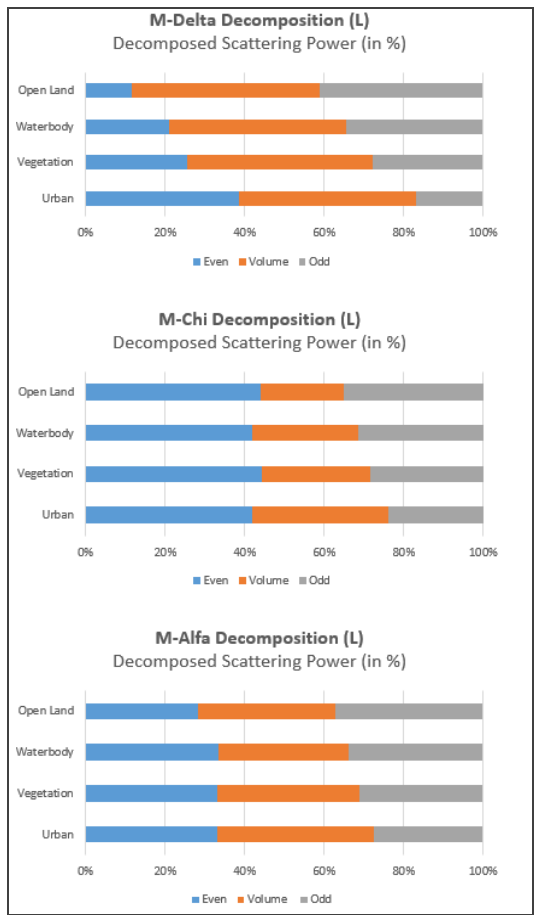
Figure 7: Percentage scattering power (Even,